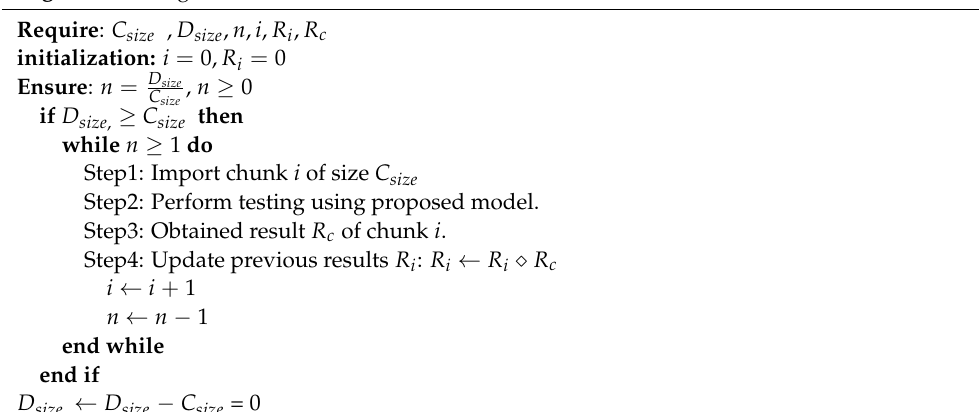
Algorithm 1: Algorithm to fetch real-time